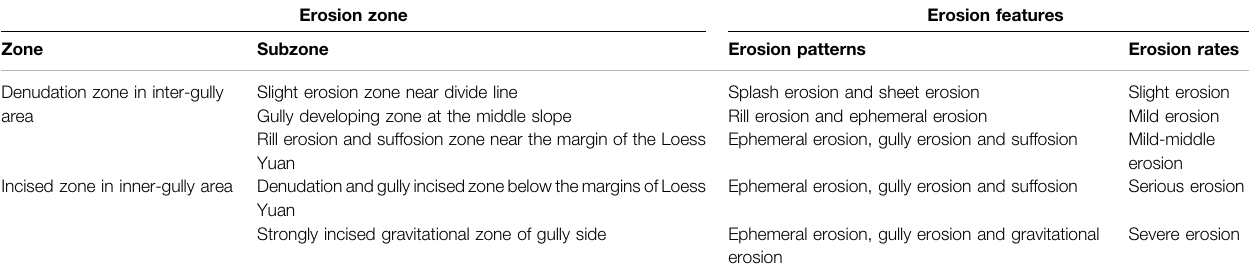
TABLE 2 | Characteristics of erosion zone for a pro fi le in the Loess fl at highland area. Erosion